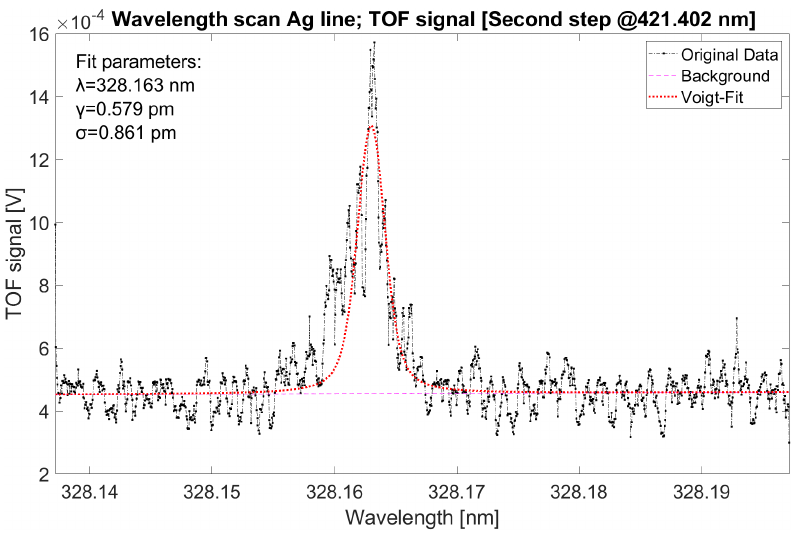
Figure 7. First-step Doppler broadening; scanned with second-step laser operating as single-mode laser @421.402 nm Scanning range = 68 pm (189.3